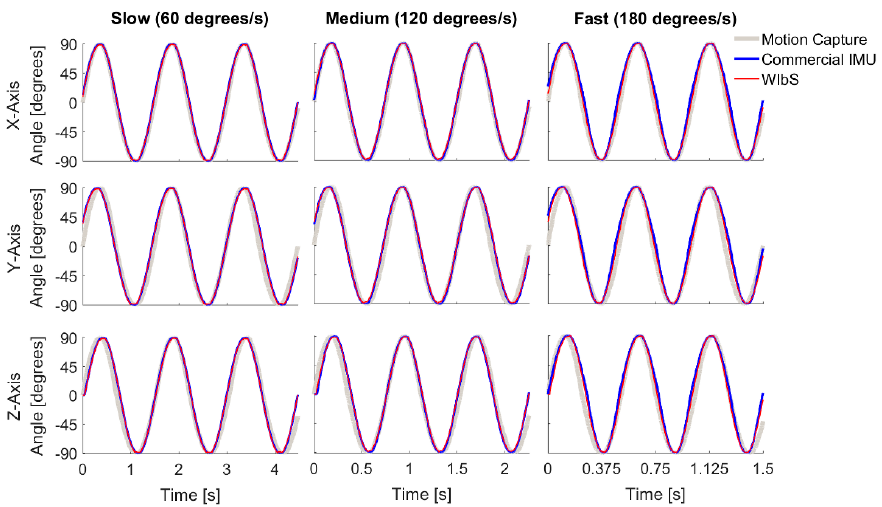
Figure 4. The sinusoidal profile results for the individual axes of the wireless inertial measurement unit-based system (WIbS), red lines, when compared to those of the commercial inertial measurement unit system (cIMU), blue lines, and the motion capture system, gray lines. The rows show results for individual axes, whereas the columns represent the tested velocities. Table 2. Accuracy and repeatability results for the Gaussian movement profile. Shown is the root- mean-square error (RMSE) for the three different movement axes and three different movement velocities: 60 degrees/s, 120 degrees/s, and 180 degrees/s.